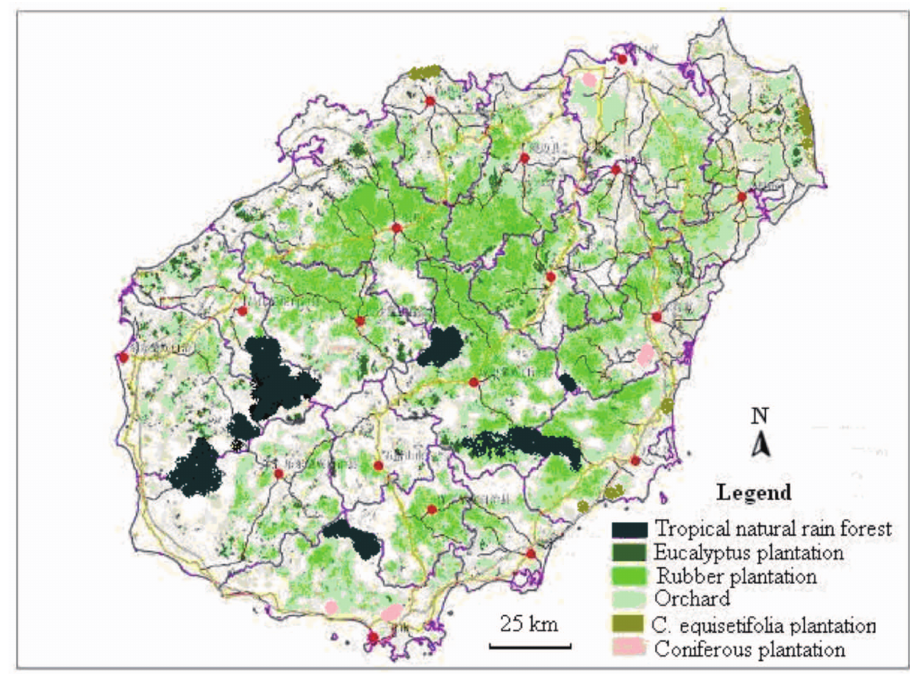
Figure 2. The distribution of forests on Hainan Island in 2008.